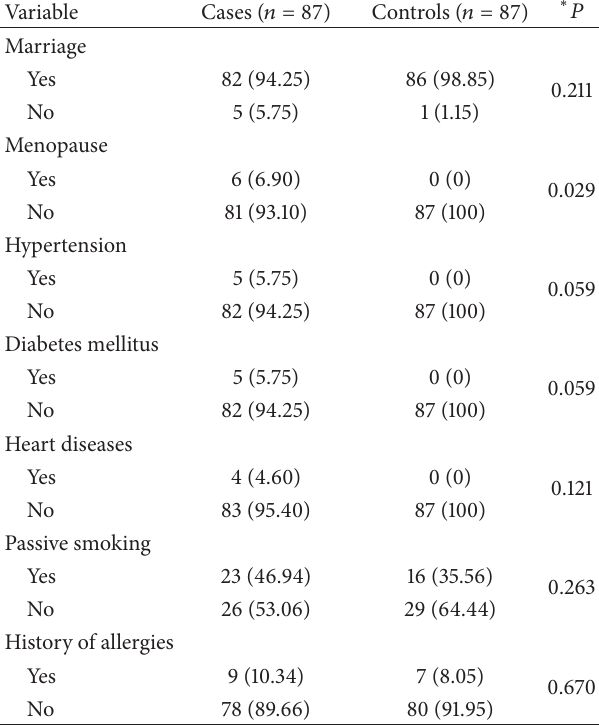
Table 1: Demographic characteristics in case and control